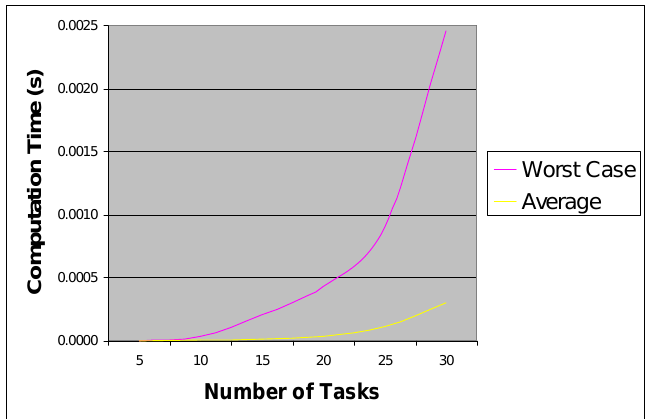
Figure 11. Running time